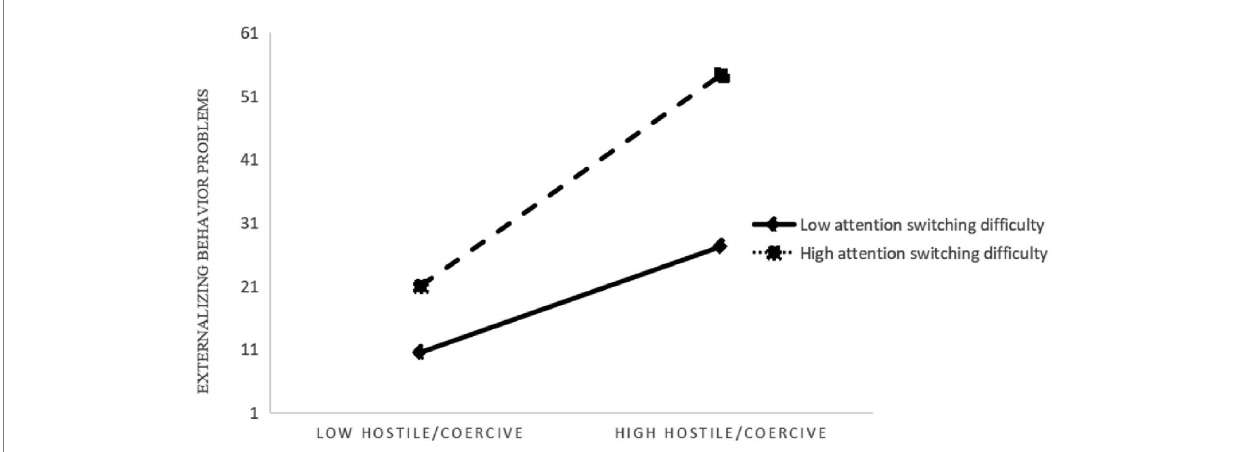
FIGURE 1 Maternal attention switching moderating the association between hostile/coercive parenting style and externalizing problems in children with ASD. At high levels of maternal attention switching problems, such that a greater use of hostile/coercive parenting style was associated with more externalizing problems in the children ( p < 0.01). By contrast, at low levels of attention switching problems, the correlation between maternal hostile/coercive parenting style and externalizing problems was non-significant ( p = 0.15). ASD, autism spectrum